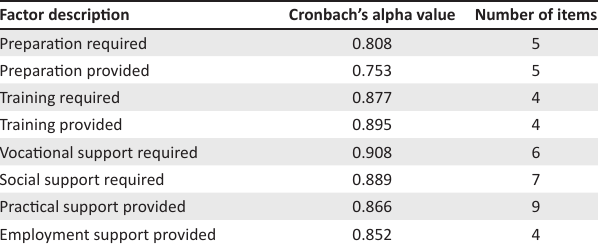
TABLE 3: Factor reliability as described by the Cronbach’s alpha